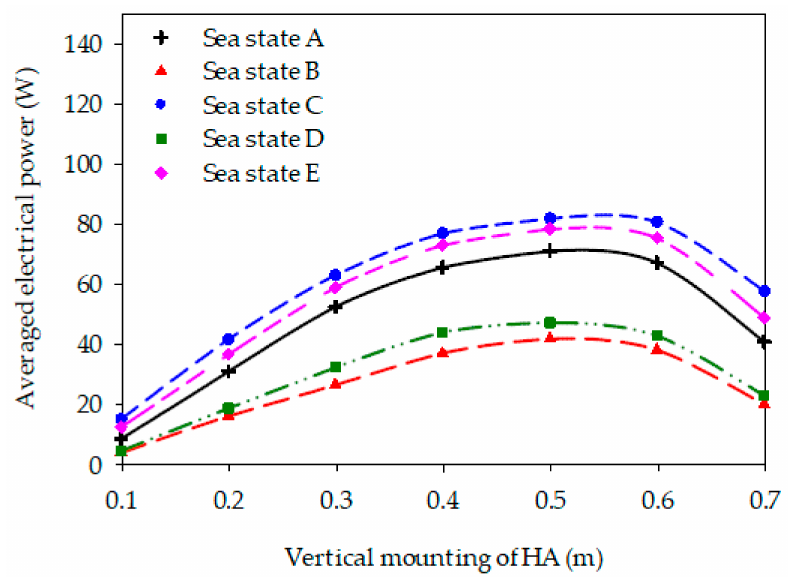
Figure 8. Averaged power of generator versus horizontal mounting distance corresponding to different sea